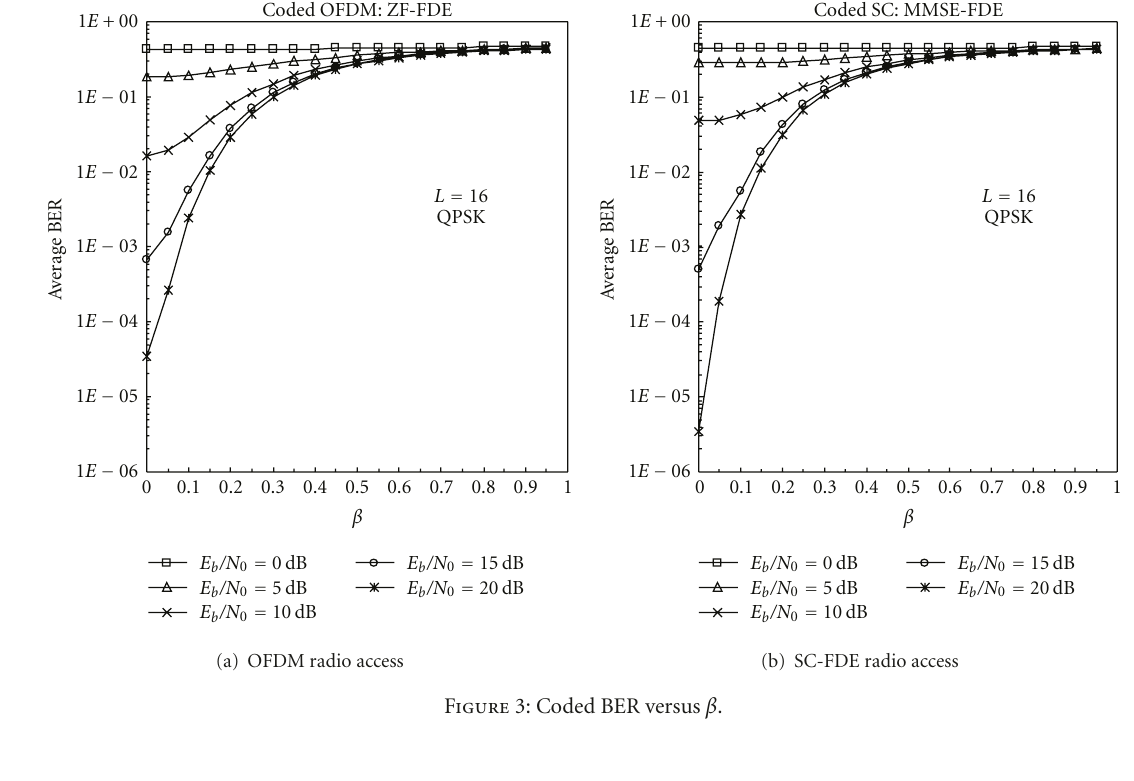
Table 2: Simulation parameters.